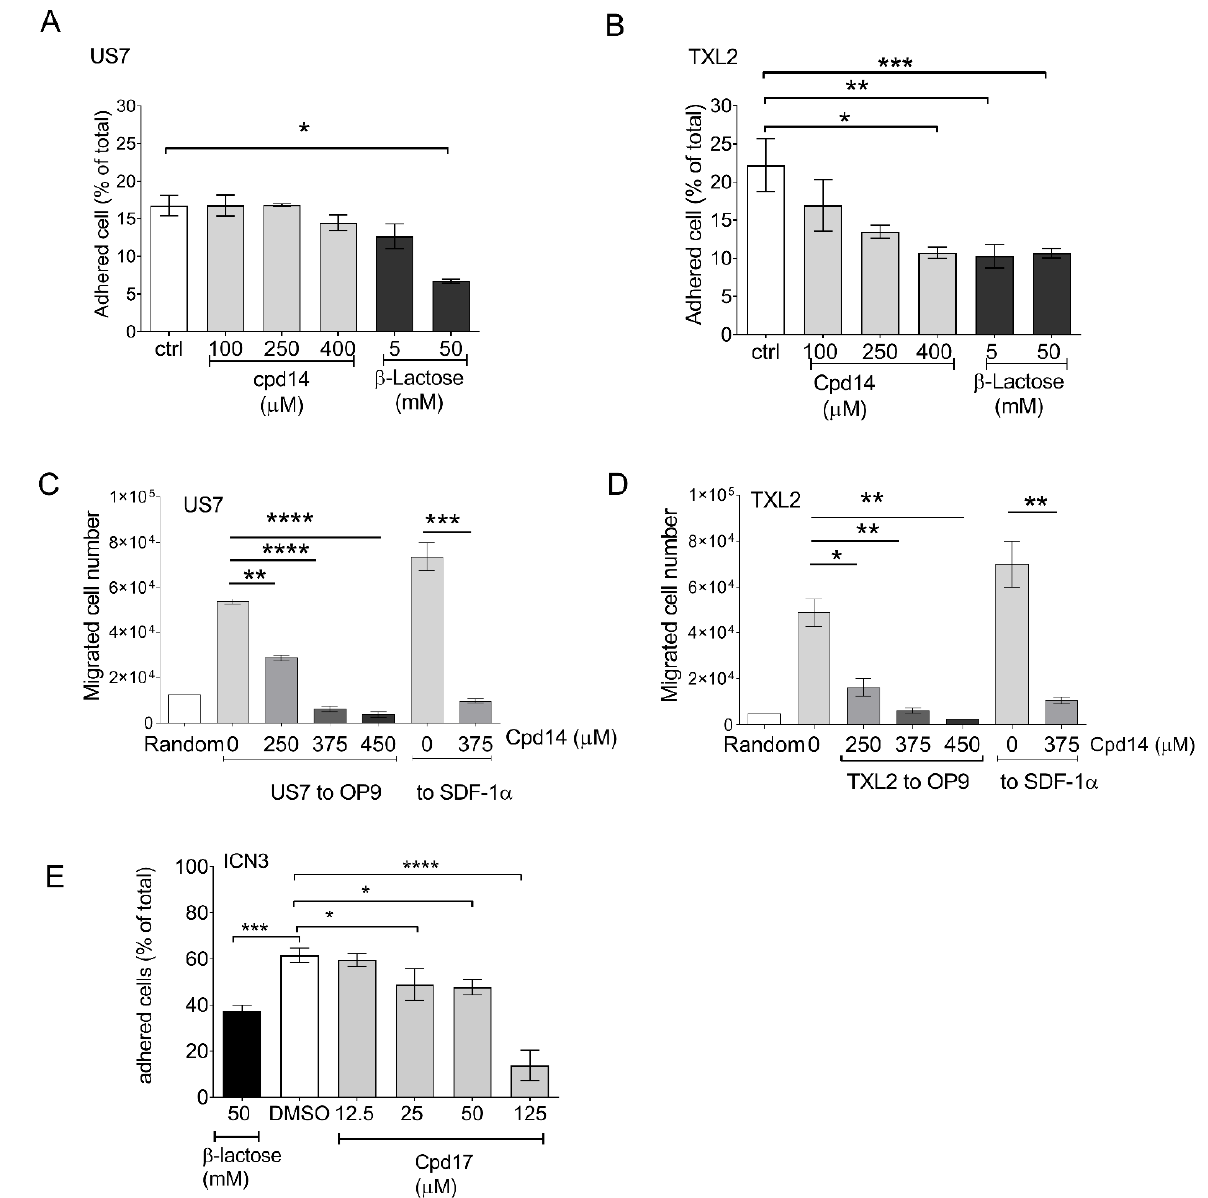
Figure 5. Effects of Cpd14 or 17 on BCP-ALL migration and adhesion. Adhesion of US7 ( A ) or TXL2 cells ( B ) to fibronectin-coated wells with and without the indicated amounts of Cpd14 in a 30-min assay. Migration of US7 ( C ) or TXL2 ( D ) to OP9 or to 200 ng/mL of the chemokine SDF-1 α (24 and 4 h, respectively) in a Transwell assay when treated with the indicated concentrations of Cpd14. ( E ) Adhesion of ICN13 cells to OP9 stroma measured after 24 h in the presence of the indicated concentrations of Cpd17. Cells in suspension and adherent to (above and underneath) the OP9 cells were harvested and counted by Trypan blue exclusion. Results are presented as percentage of living [Trypan-blue excluding] leukemia cells adhering to OP9. Error bars, mean ± SEM of triplicate values for panels ( A , B , E ) or duplicate wells for panels ( C , D ); ctrl, DMSO control. One-way ANOVA, Dunnett;’s multiple comparison test. Adjusted p -values. * p < 0.05, ** p < 0.01, *** p < 0.001, **** p < 0.0001.